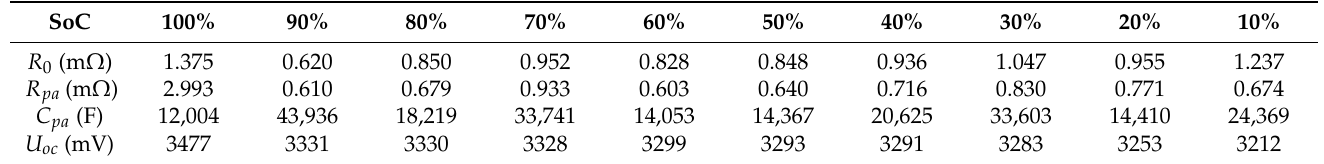
Table 2. Thevenin model parameters under different SoC points.